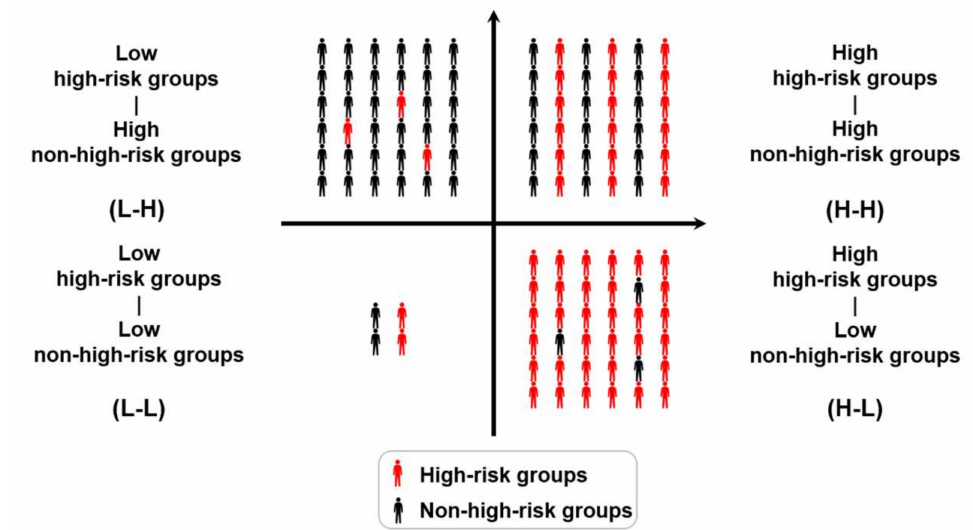
Figure 2. Overview of the four aggregation patterns of